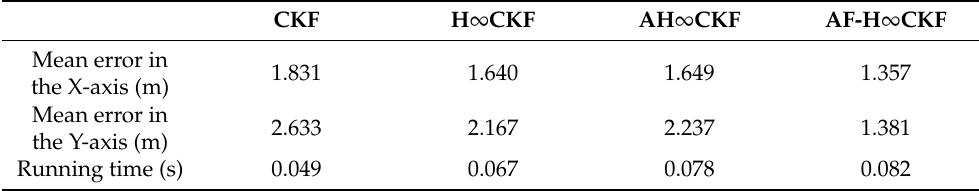
Table 1. Comparison of the four algorithms in Case